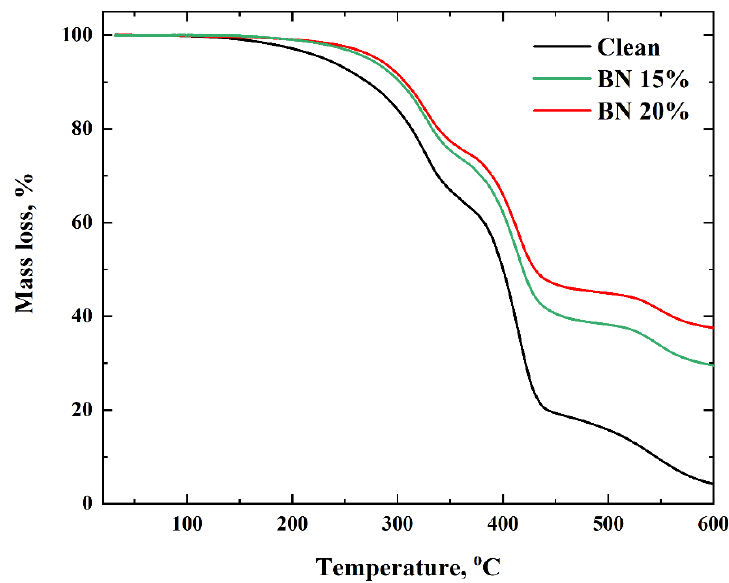
Figure 3. TGA analysis of the samples.